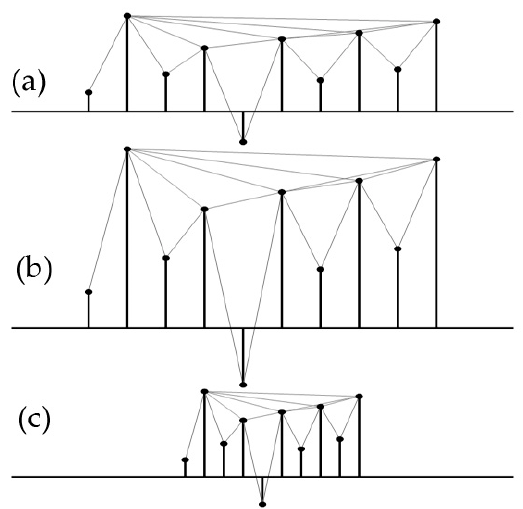
Figure 3. The visibility remains invariant under horizontal and vertical transformation of the time series. ( a ) Visibility links of the original time series; ( b ) Resizing vertically; ( c ) Resizing horizontally.